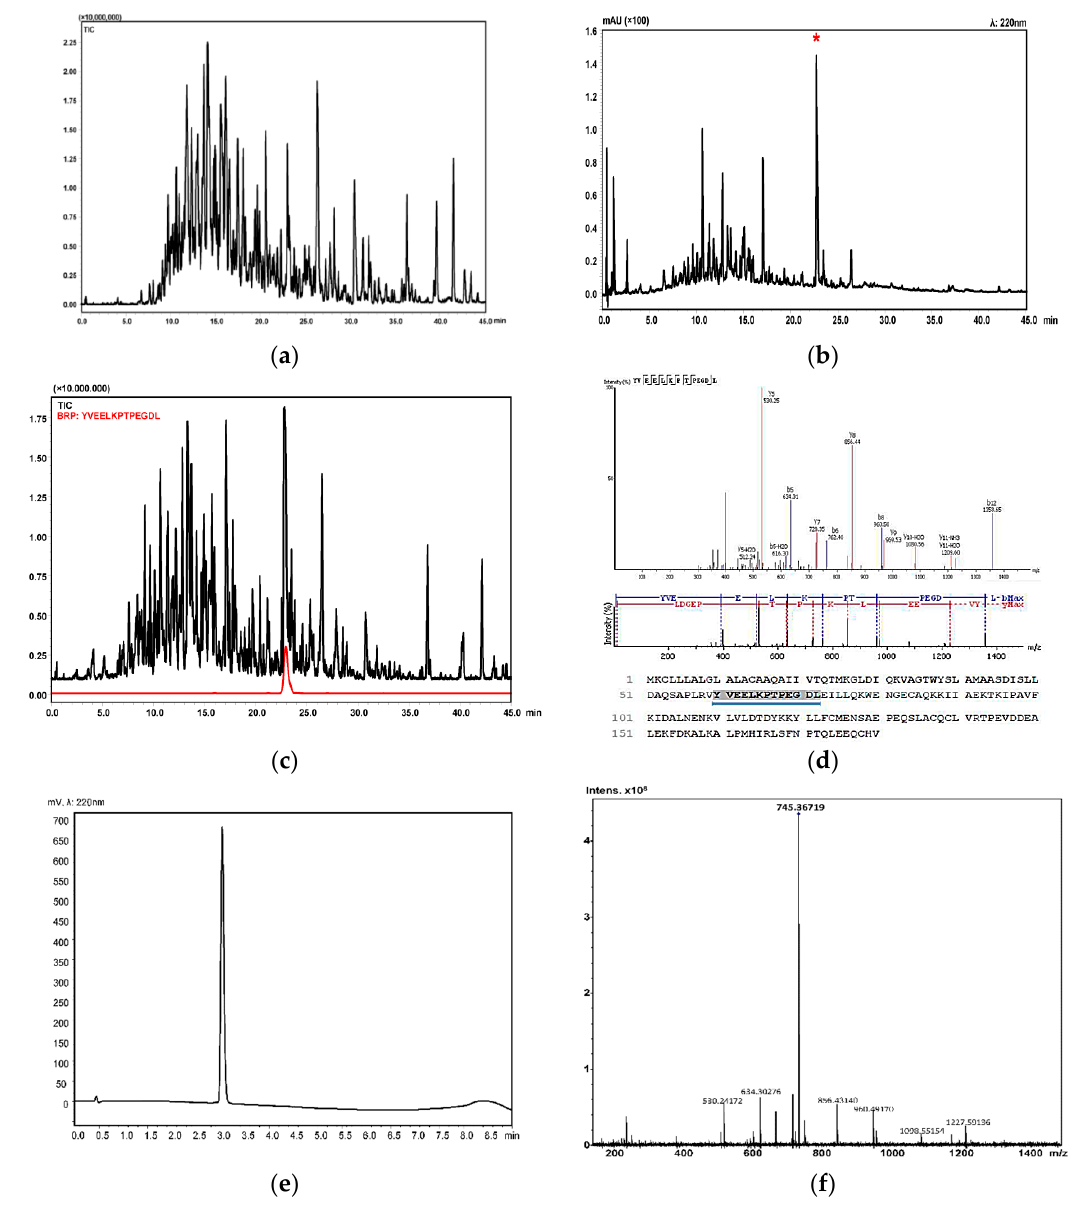
Figure 2. ( a ) Total ion chromatogram (TIC) of peptides released during in vitro gastrointestinal digestion of buffalo ricotta cheese; ( b ) chromatographic profile and ( c ) TIC of peptide fraction with molecular weights between 1 and 3 kDa (F up ); ( d ) fragmentation pattern of BRP; ( e ) chromatogram acquired by RP-UHPLC-UV; and ( f ) mass spectrum of the synthetic BRP obtained by direct infusion Fourier transform ion cyclotron resonance